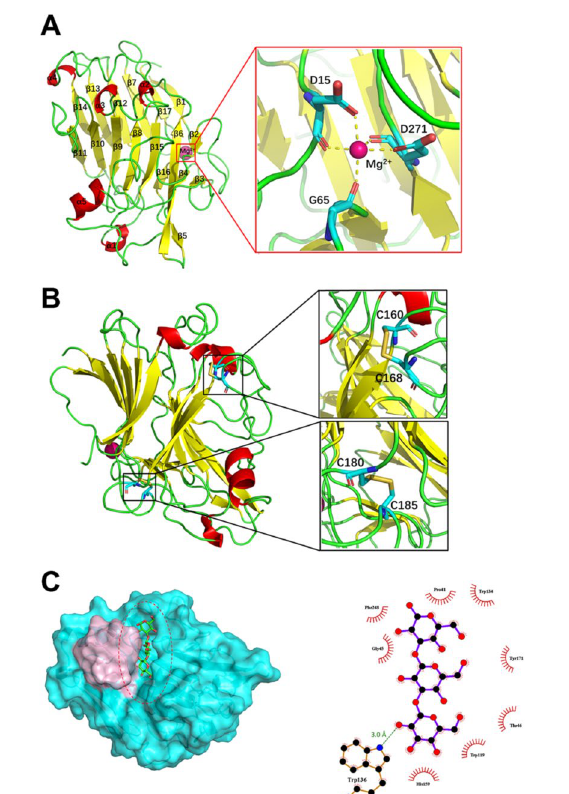
Fig. 4 Structural analysis of the catalytic domain (Actglu-CD) of β-1,3-glucanase. A the overall structure. β-sheets, yellow; α-helix, red; Mg 2 + , bright pink; all loops, green. B two disulfide bonds in the structure (between C160 and C168, and between C180 and C185). The model in Panel B is rotated 90° around the Y-axis. C molecular docking shows the ligand binding cleft in Actglu-CD. The disulfide bonds are located in a region (light-pink, residues 156 –174) near the active site, which is illustrated by a red dashed